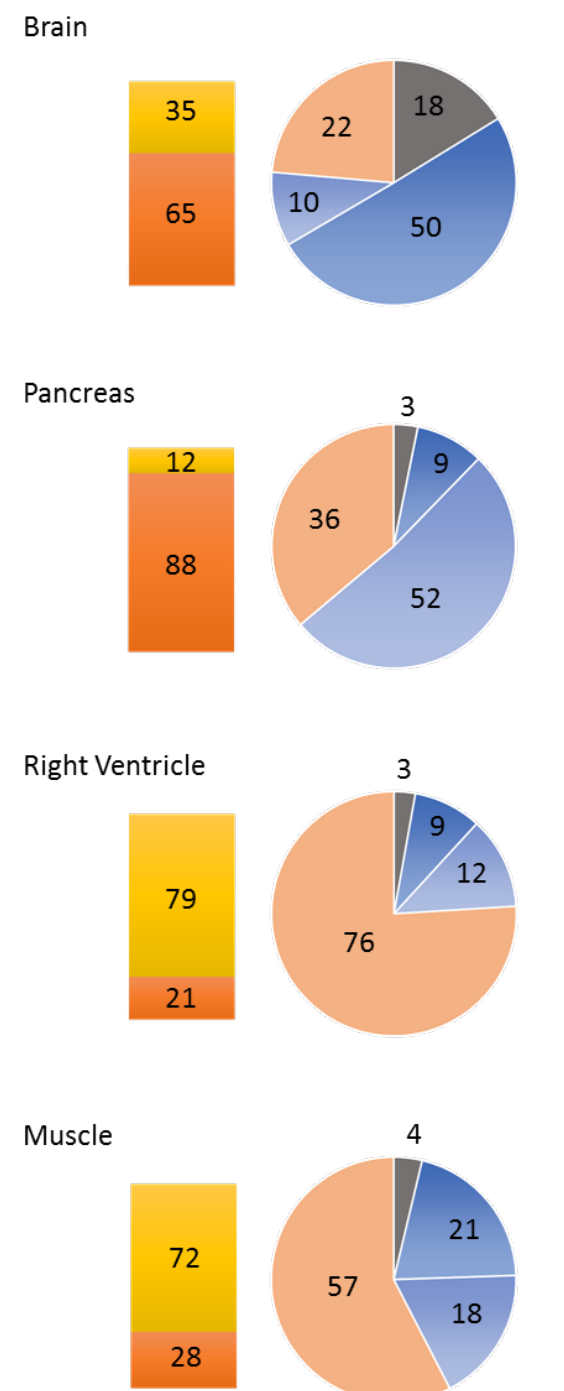
Figure 2. PC double bond (DB) index and docosahexaenoic acid (DHA) to arachidonic acid (AA) ratios in various organs. The relative percentage of PC species bearing no double bond (DB = 0), one double bond (DB = 1), two double bonds (DB = 2), and >two double bonds (DB > 2) in their acyl chains were obtained from the PC subspecies distribution displayed in Figure 1. The ratio of DHA (PC 36:6, 38:6, and 40:6) to AA (PC 36:4, 38:4, and 40:4)-containing PC subspecies in the various organs is also displayed and was calculated from the values presented in Figure 1. The percentages of the various subspecies are indicated.